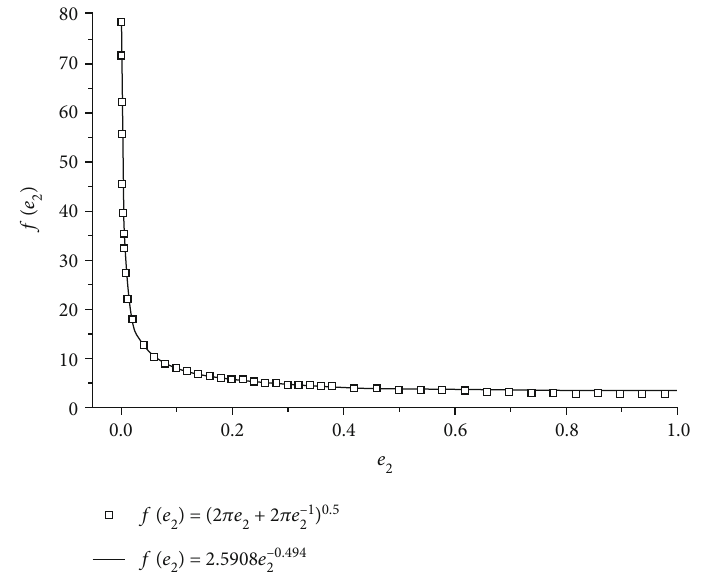
Figure 2: Theoretical and fi tting functions of f ð e